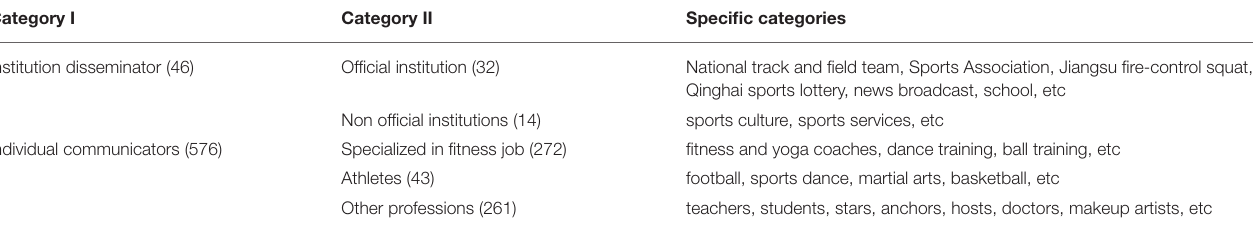
TABLE 1 | Occupational characteristics of the disseminators of short fitness videos on TikTok.